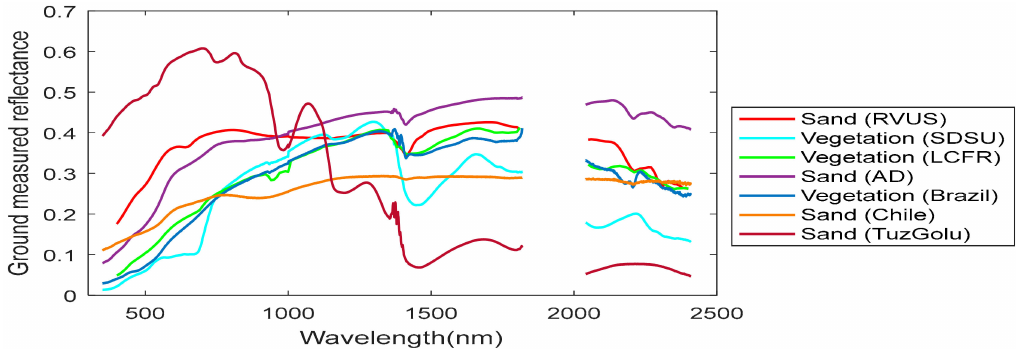
Figure 4. Hyperspectral surface reflectance curves over all ground truth sites selected to validate the Operational Land Imager Surface Reflectance (OLI SR) product in this study. Results are obtained from manual walked field spectrometer measurements and in-situ calibrated hyperspectral instrumentation